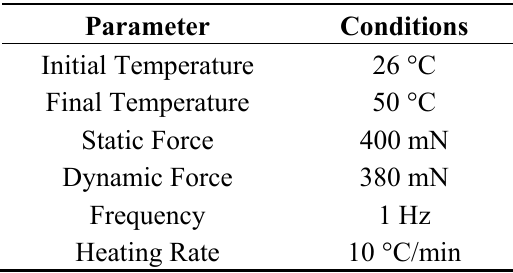
Table 3. The DMA parameters used in temperature